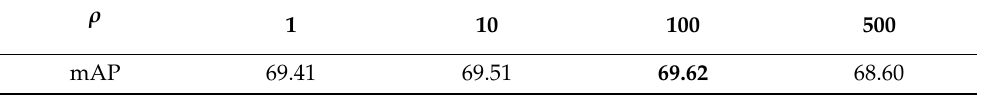
Table 10. The influence of ρ on retrieval. The maximum mAP value is